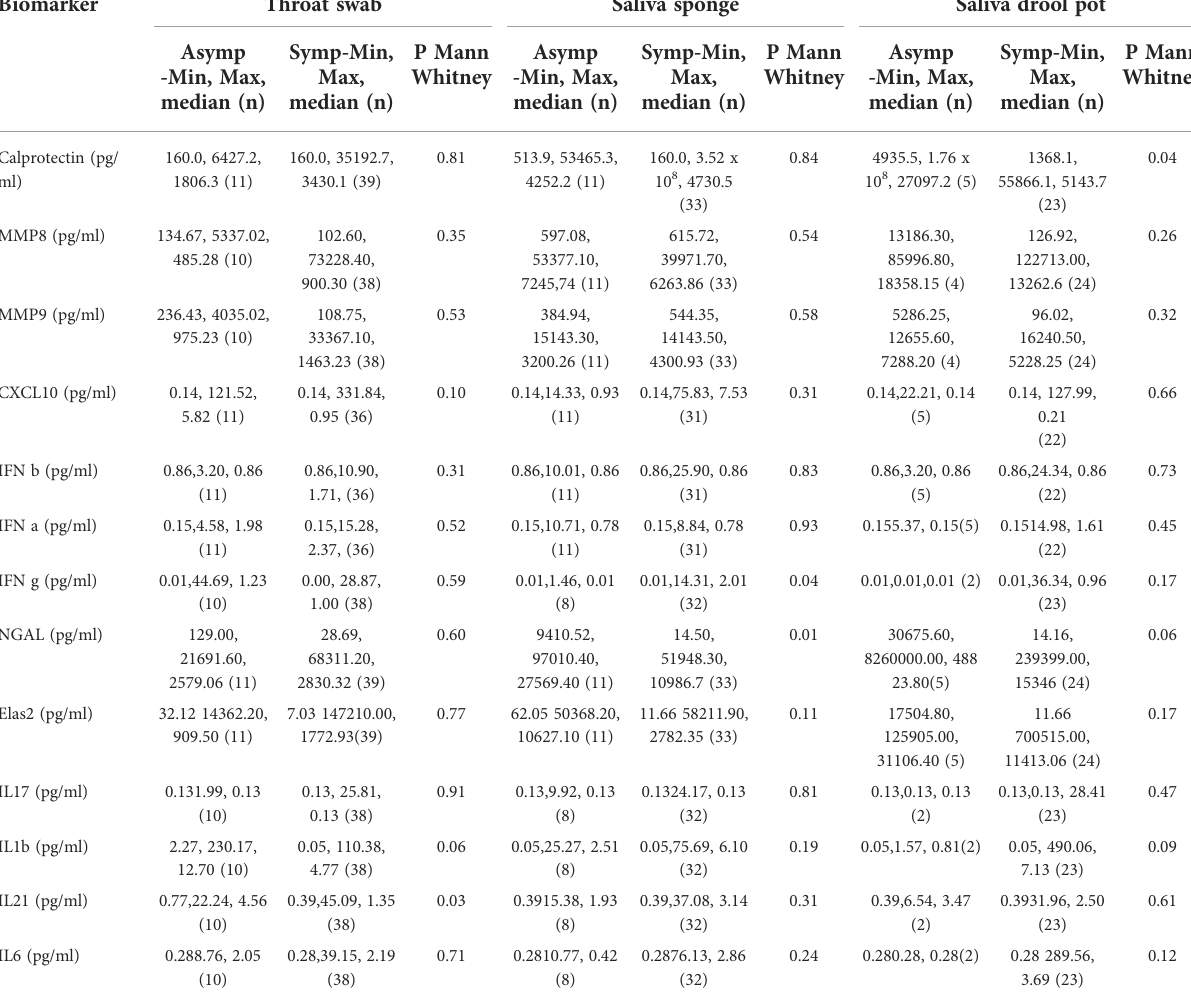
TABLE 6 Biomarker concentrations detected in throat swabs and saliva samples.